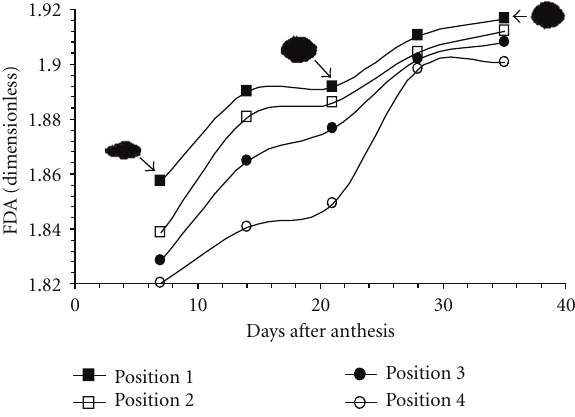
Figure 6: Evolution of fractal dimension of area (FDA) during grain filling and maturation of rice Morelos A-98. Objects represent bina- rized projected area of OM (3X) micrograph of grain transversal